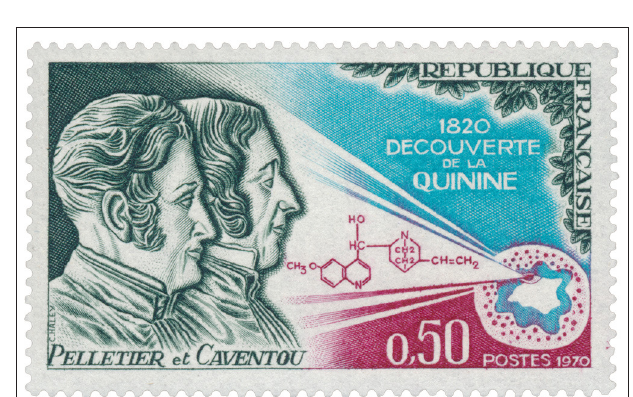
FIGURE 3 | Postage stamp edited in 1970 with the images of Pelletier and Caventou, who first isolated the active ingredient “quinine”.